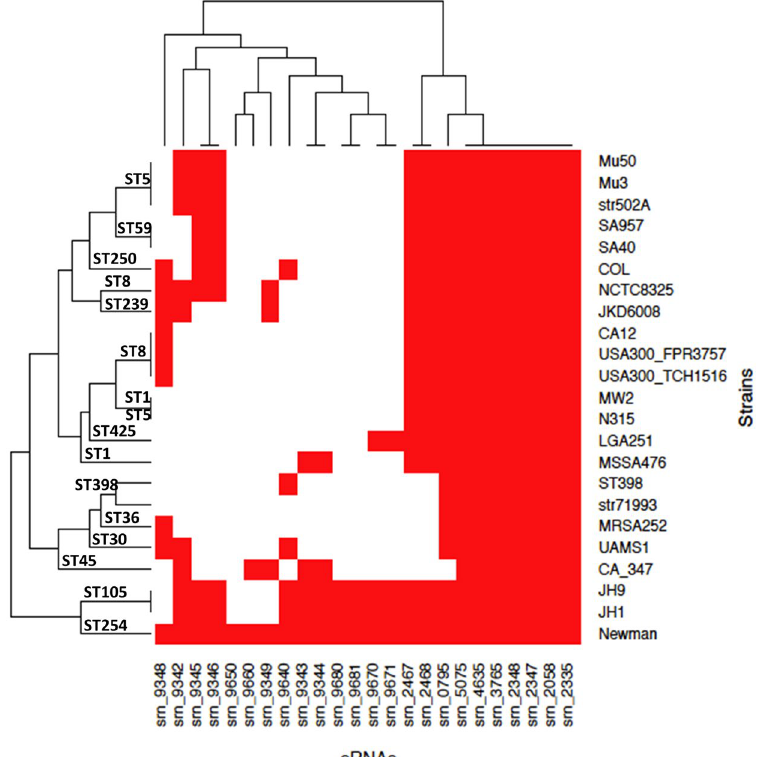
Figure 4. Comparative analysis of the presence and absence of novel srns in Staphylococcus strains. A heat map was generated based on the presence (red) and absence (white) of srns in strains belonging to various clonal complexes. The data were clustered based on srns and genome sequence